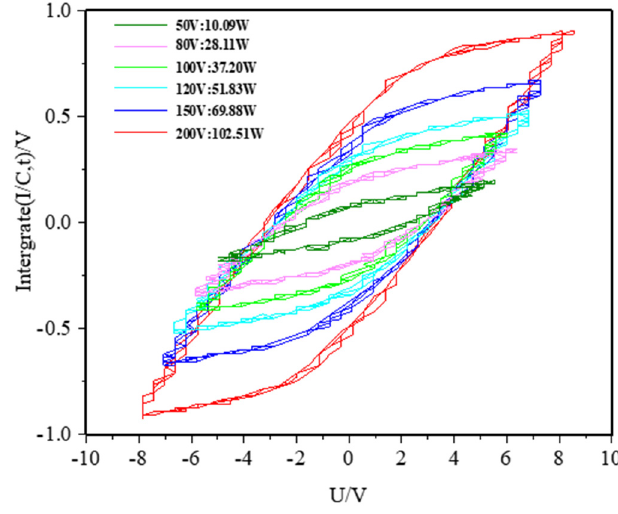
Figure 8. Lissajous plots of different applied voltages on the MnTi catalyst.